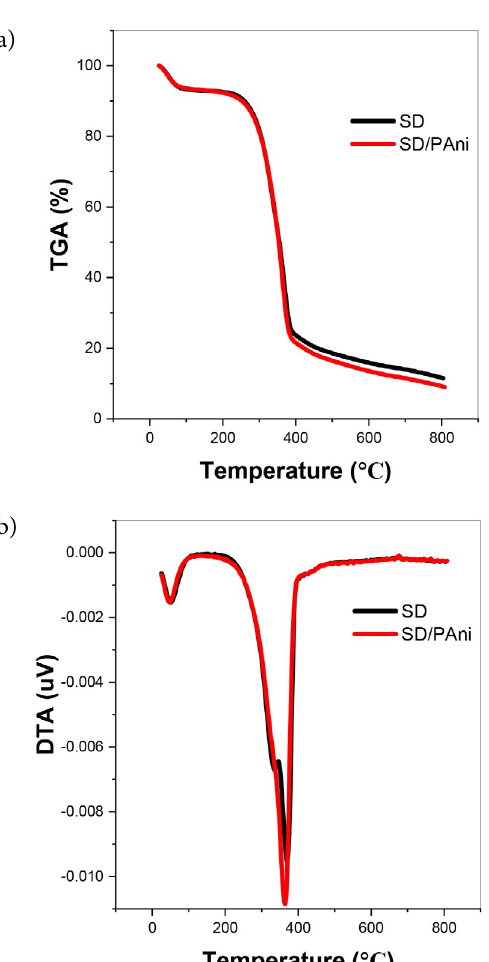
Fig. 3. TGA (a) and DTA (b) curves of sawdust and